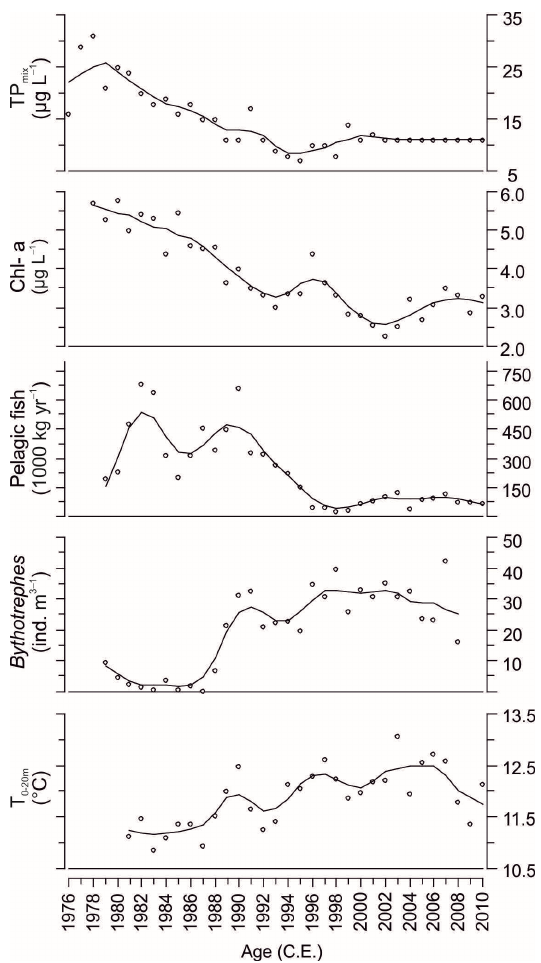
Figure 2. Real time observations in the long-term changes in Lake Maggiore total phosphorus at winter mixing (TP mix , since 1976), chlorophyll-a concentration (Chl- a , since 1978), pelagic fish